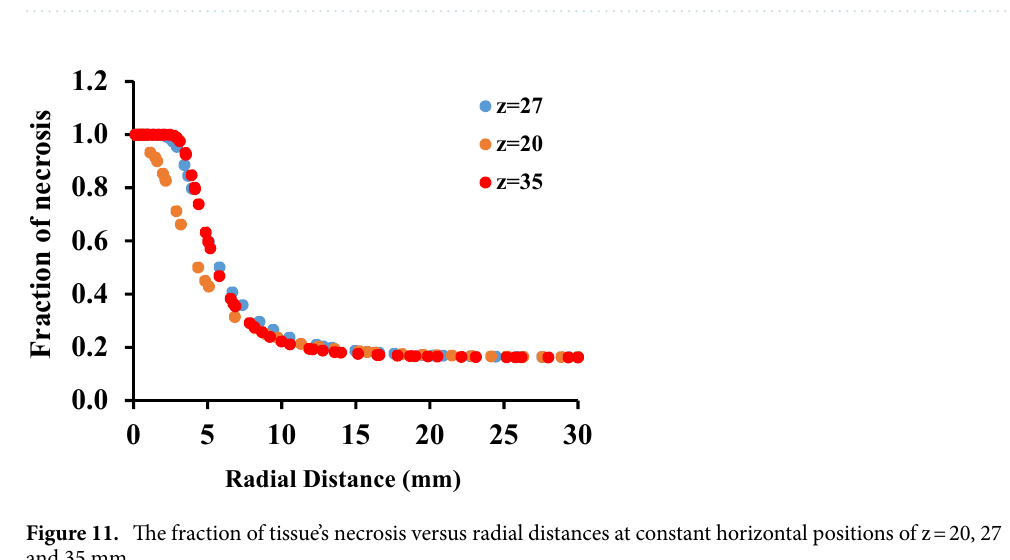
Figure 10. Six horizontal and vertical lines for estimation of the amount of damage to the neighbor areas of tumor.